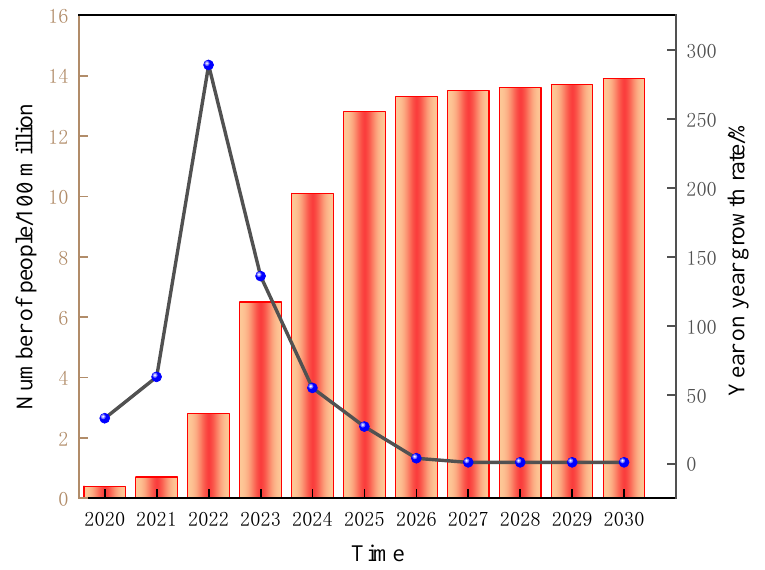
Figure 1. Forecasted numbers of 5G subscribers in China from 2020 to 2030 [1].